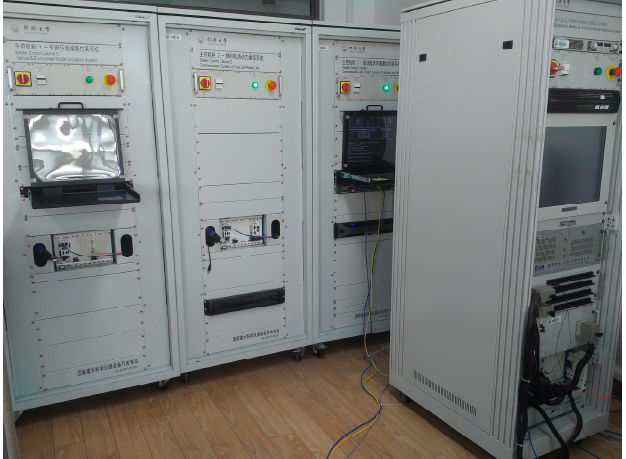
Figure 7. Main controller cabinet of the testing platform.